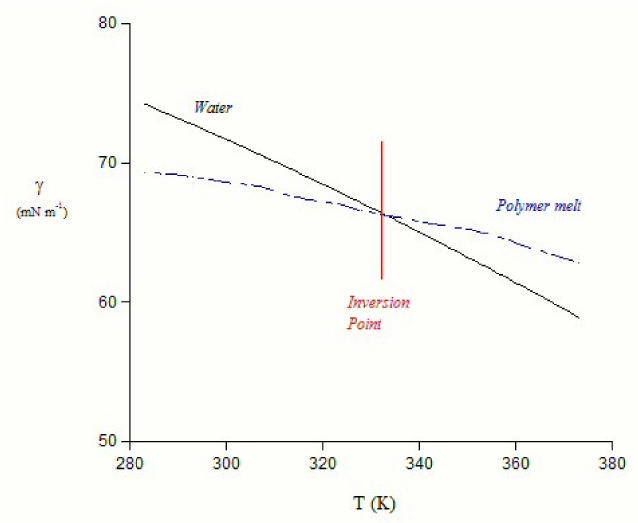
Figure 3. Surface tension of a water / polymer mixture as a function of temperature, in K: the vertical line in the center indicates the inversion temperature, T inv , below which the polymer is surface-depleted. At T below the “inversion point”, the polymer prefers being in the surface phase. If a solid is present, surface stabilization occurs from this point